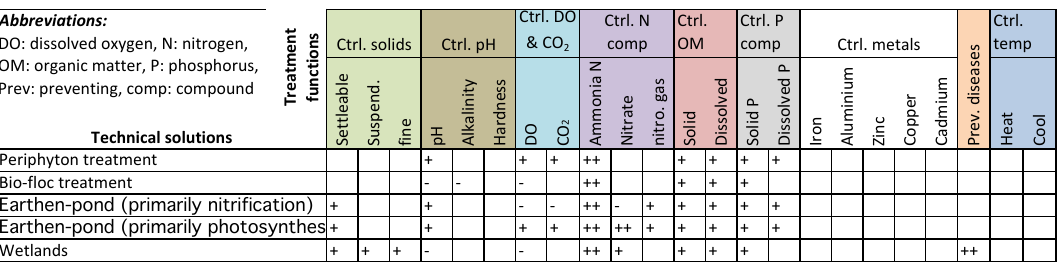
Table 5. QFD matrix presenting how periphyton, bio-floc, earthen-ponds and wetlands influence different treatment functions.